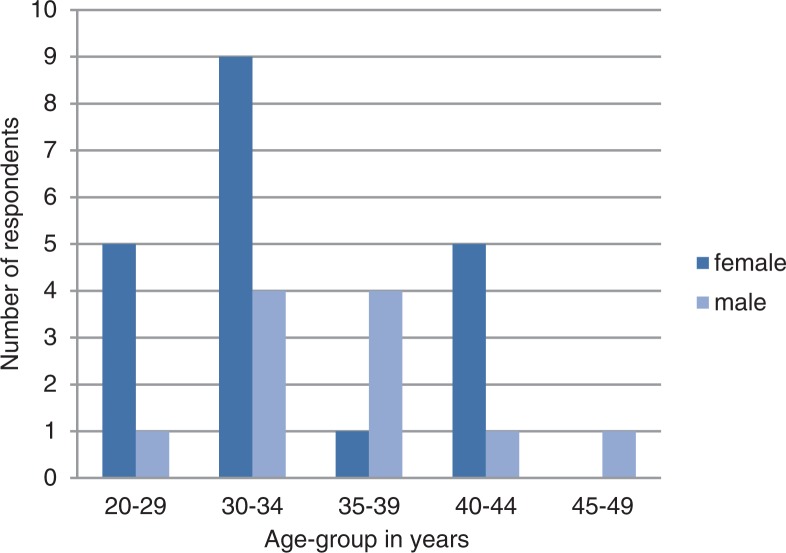
Age and gender of respondents (n=31).